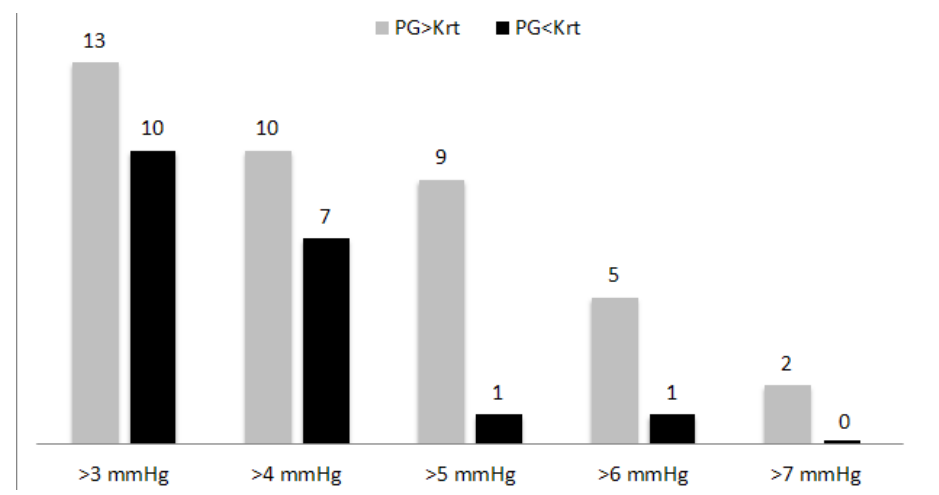
Figure 5. The number of examinations in which SBP 3, 4, 5, 6 and 7 mmHg. SBP which SBP was higher than SBP K